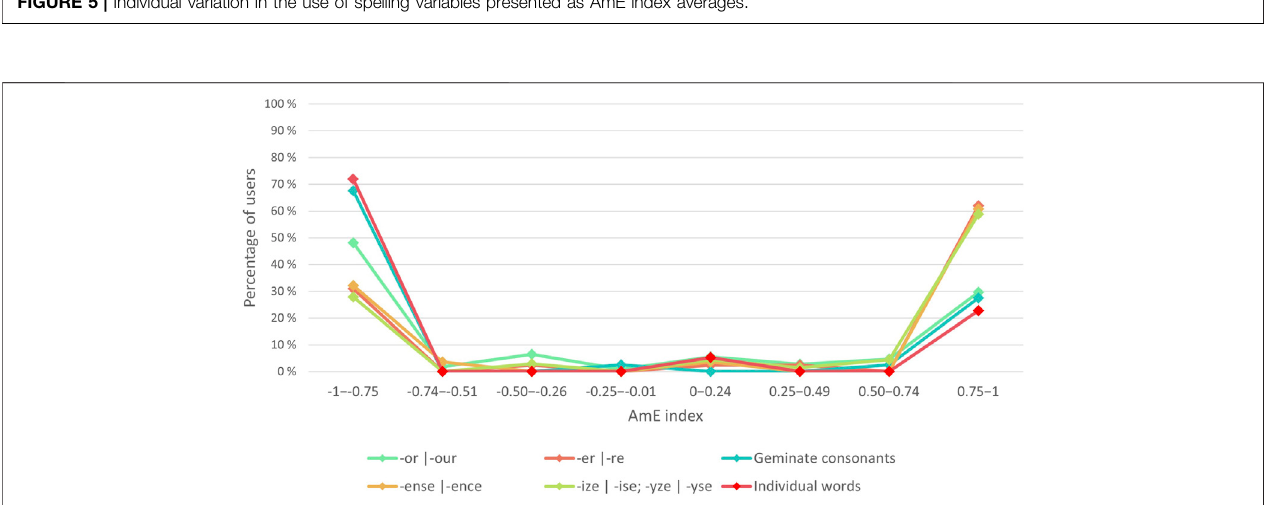
FIGURE 5 | Individual variation in the use of spelling variables presented as AmE index averages.